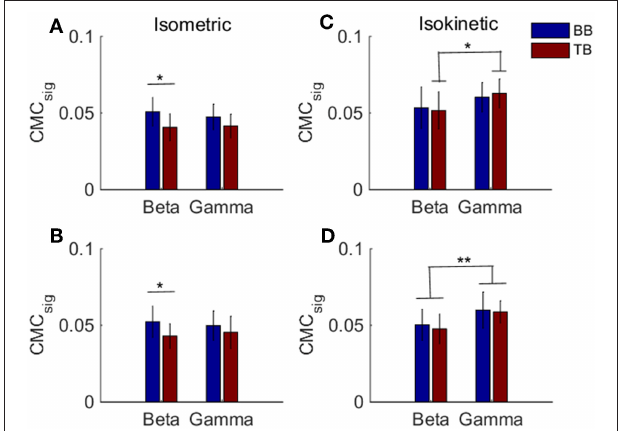
FIGURE 7 | Grand averages of the CMC sig values for BB and TB when muscles acted as agonist during the contraction stage of isometric exercise and isokinetic movement, in beta- and gamma-range, respectively. For isometric exercise, (A,B) show the CMC sig values under C1 and C5 electrodes, respectively. For isokinetic movement, (C,D) show the CMC sig values under C1 and C5 electrodes, respectively. We denoted the significance with the star mark. * p < 0.05 and ** p < 0.01. Error bars show the standard error of the